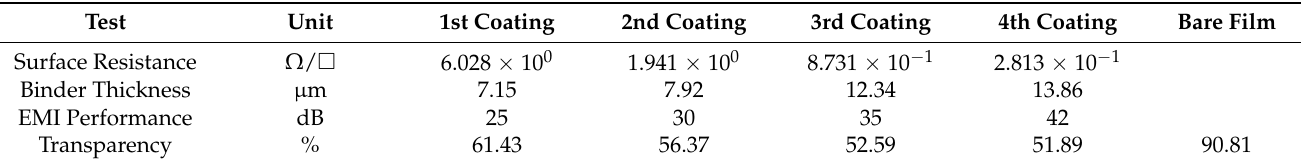
Table 3. Evaluation of the changes in film properties according to coating conditions.